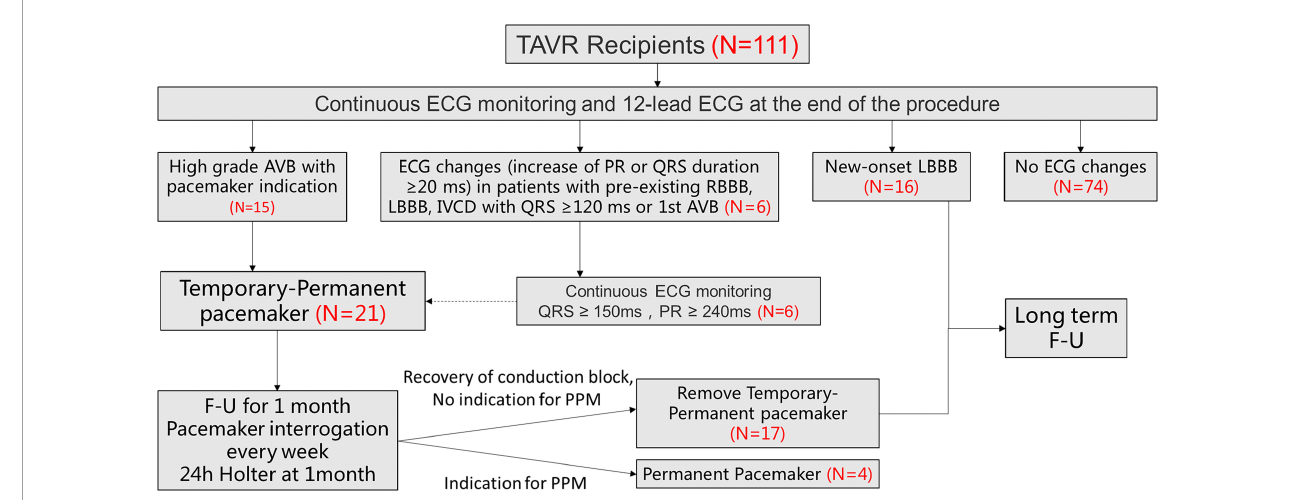
FIGURE2 Patient flowchart. The overall population included 111 patients who underwent TAVR screened for TPPM. 21 patients ultimately underwent TPPM including 15 with HAVB and 6 with further ECG changes (increase of PR or QRS duration ≥ 20 ms, meanwhile QRS > 150 ms and PR > 240 ms). TAVR, transcatheter aortic valve replacement; ECG, electrocardiogram; HAVB, high-degree atrioventricular block; LBBB, left bundle-branch block; TPPM, temporary permanent pacemaker; F-U, follow up.